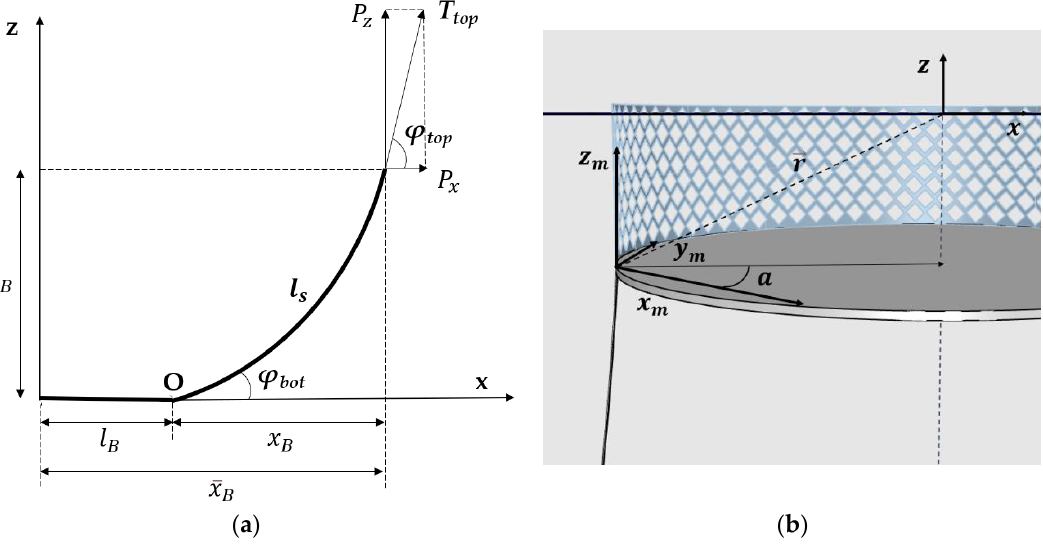
Figure 2. Representation of mooring cable and global coordinate system: ( a ) schematic representation of a 2D typical mooring line; ( b ) depiction of the mooring cable and global coordinate system orientation.